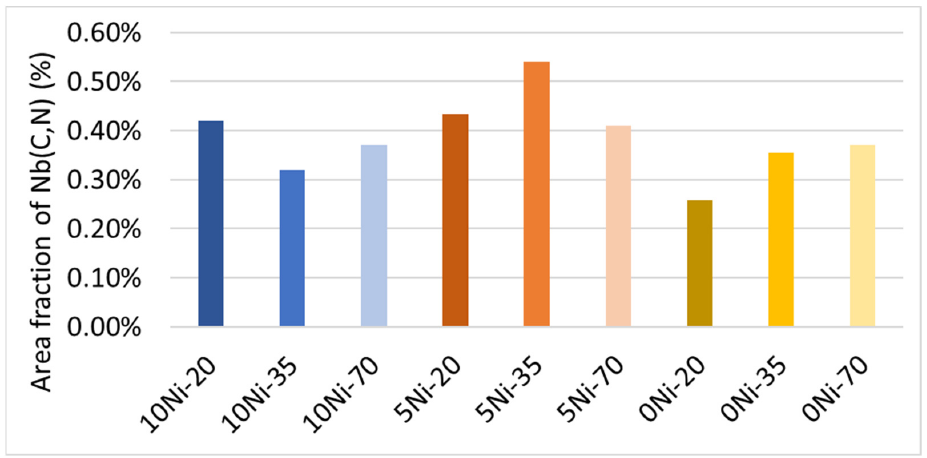
Figure 12. Influence of cooling rate and nickel content in as-cast samples on area fraction of carboni- trides. of